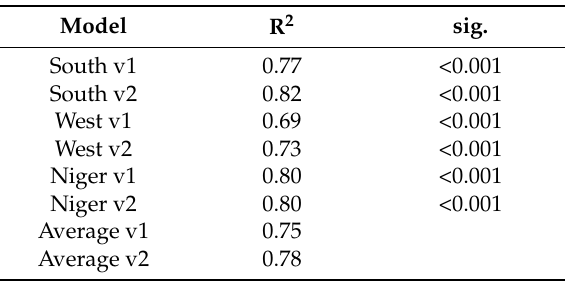
Table 5. Soil Moisture Validation against ESA CCI